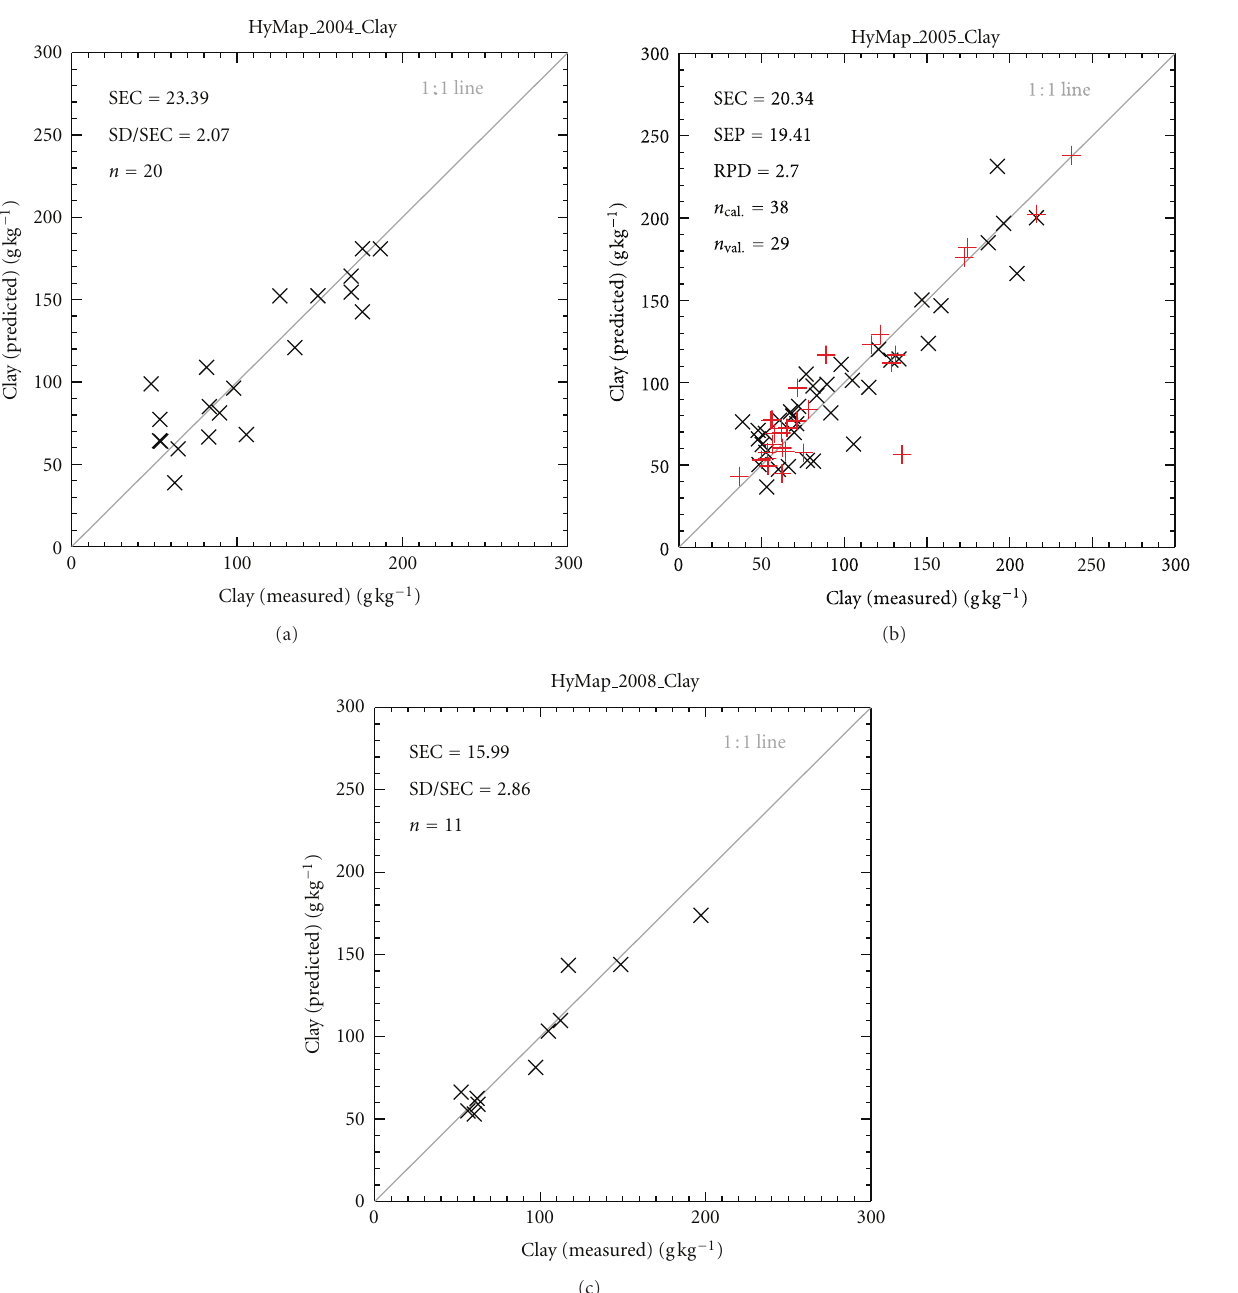
Figure 10: Plots of measured versus predicted values for clay (g kg − 1 ) in the calibration (black symbol, × ) and validation (red symbol, +) data sets based on HyMap image spectra. The respective calibration and validation data schemes ( n cal . / n val . ) are marked on the plots. For further explanation see